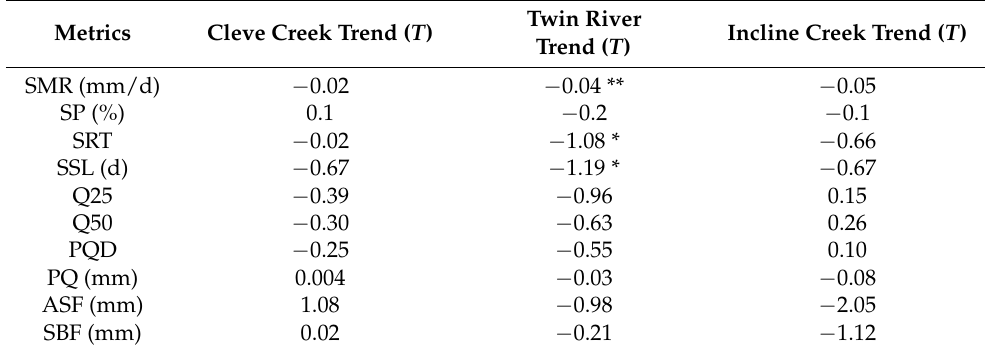
Table 2. Trends of snow and flow metrics in three